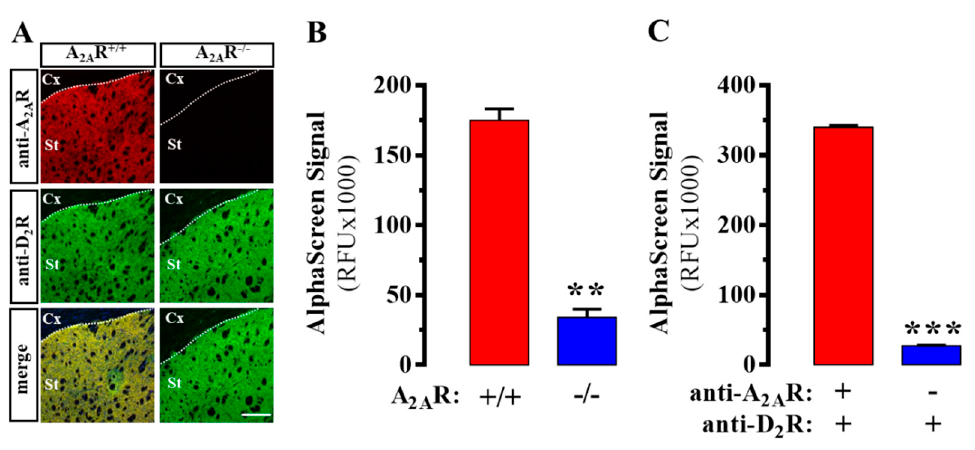
Figure 2. A 2A R/D 2 R heteromer assessment in mouse striatum and human caudate using AlphaScreen. ( A ) Representative images of A 2A R and D 2 R immunoreactivities in the dorsal striatum of wild-type (A 2A R +/+ ) and A 2A R -/- CD-1 mice. Cx, cortex; St; striatum. (see Methods). Scale bar: 350 µm. ( B ) AlphaScreen signal obtained in striatal slices from A 2A R +/+ and A 2A R -/- CD-1 mice (see Methods). ( C ) AlphaScreen signal obtained in human caudate, either with or without using the two primary antibodies (see Methods). Results are presented as mean ± SEM of three independent experiments performed in triplicate. ** p < 0.01, *** p < 0.001, Student’s t -test.